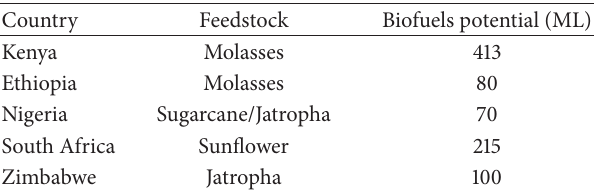
Table 1: Biofuels production potential of some African countries in megaliters